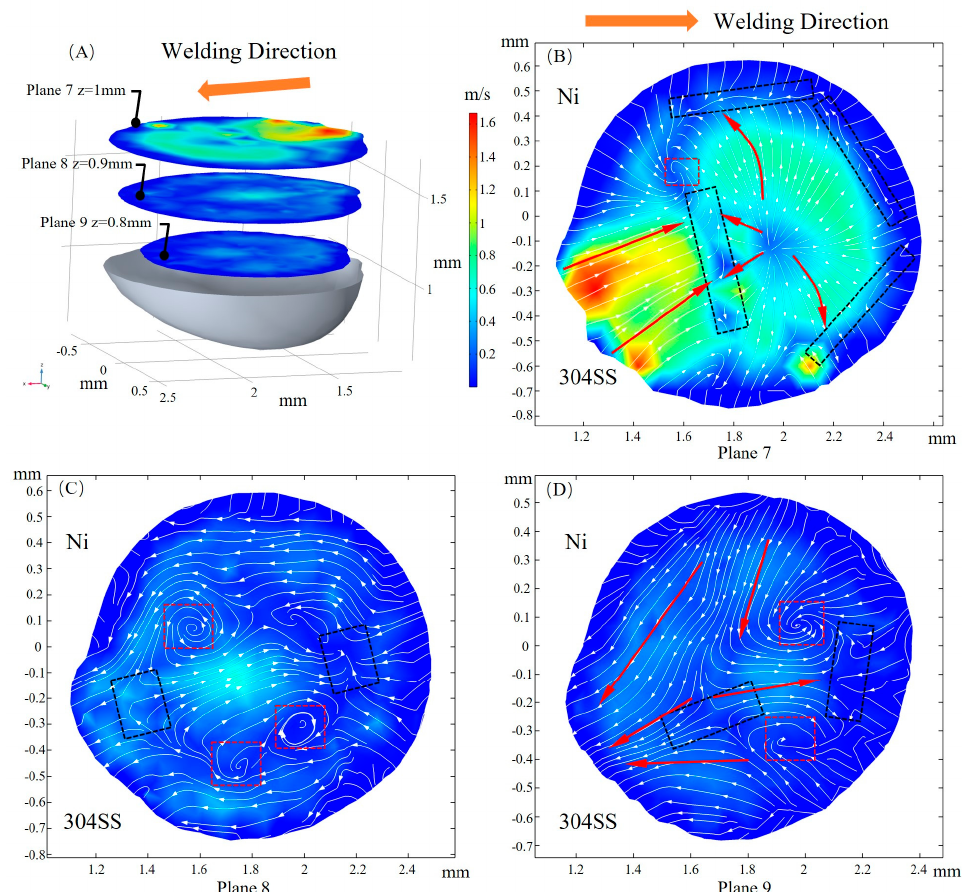
Figure 11. Fluid fl ow in the xy cross section. ( A ) 3D view; ( B ) z = 1 mm; ( C ) z = 0.9 mm; ( D ) z = 0.8 mm.